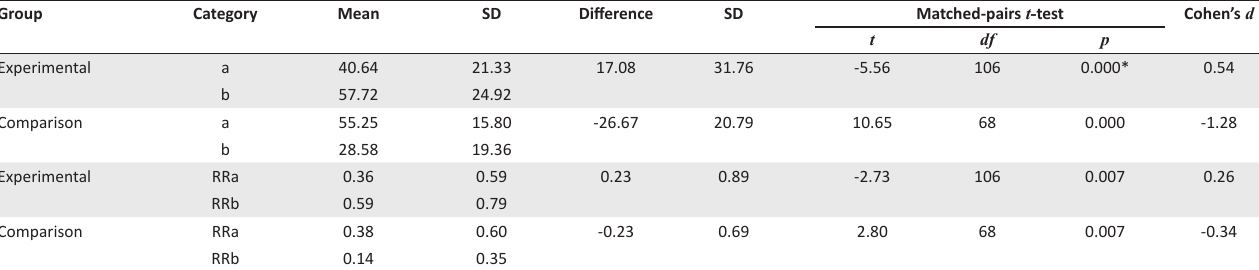
TABLE 4: A test of a significant mean difference (pre-tests and post-tests in the experimental and comparison groups using a matched-pairs t -test).